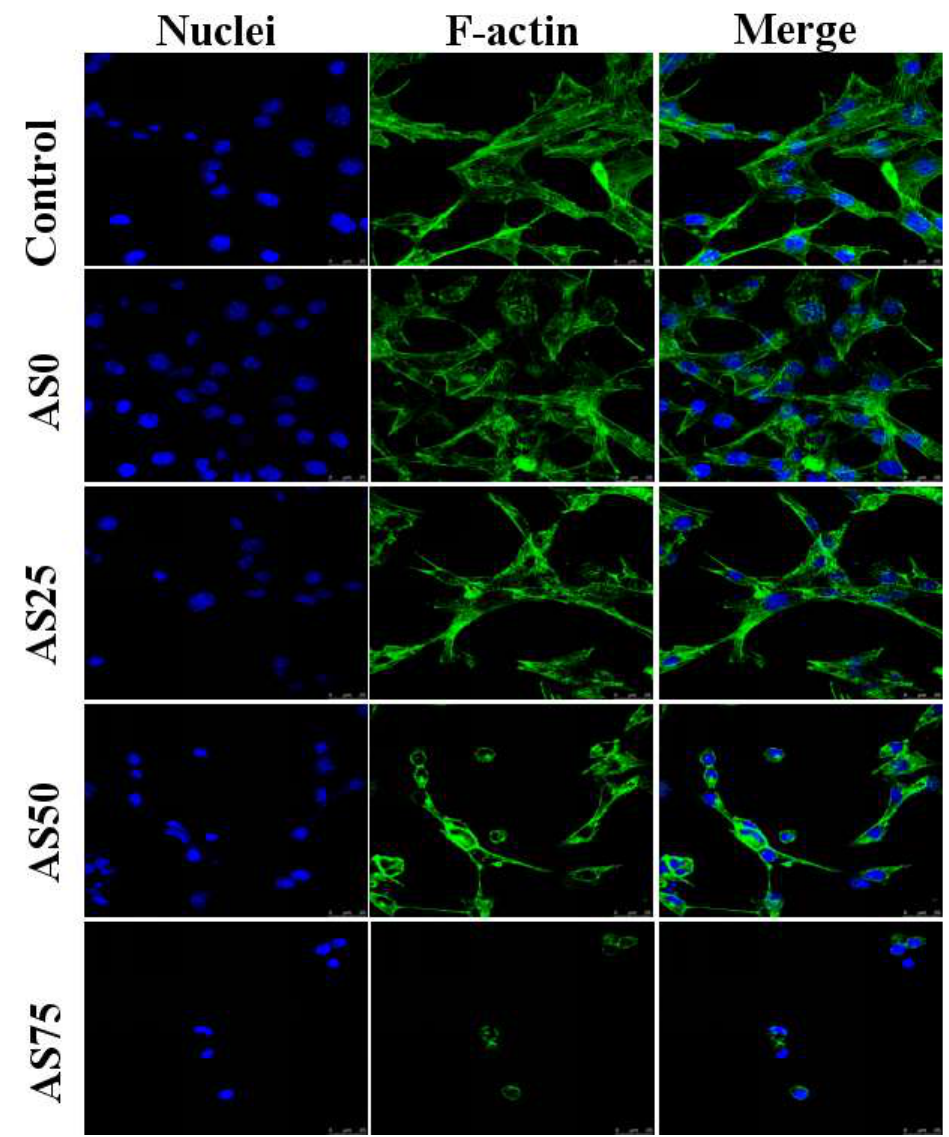
Figure 12. CLSM images of NIH3T3 cells cultured for 24 h of four groups of hydrogels (AS0, AS25, AS50, AS75) showing nucleus stained with DAPI (blue) and F-actin stained with FITC-phalloidin (green).